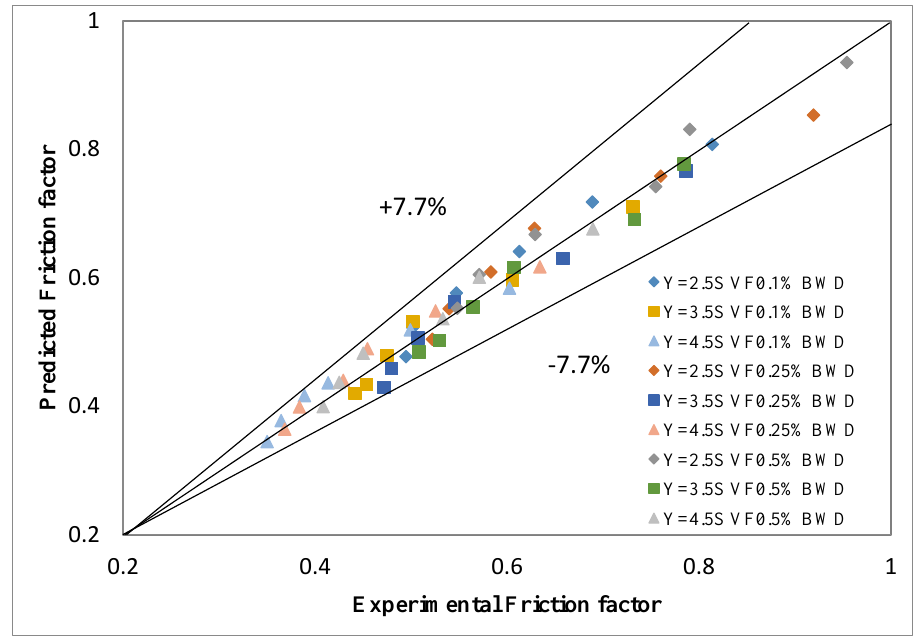
flow conditions. Energies 2020 , 13 , x FOR PEER REVIEW